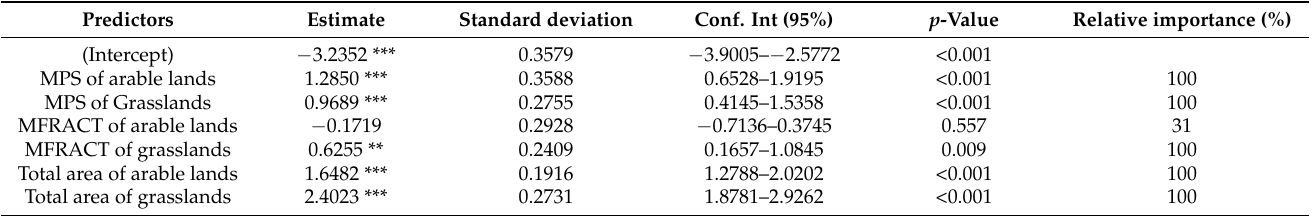
Table A2. Summary table for landscape metrics and LULC categories, which shows the GLM results after multimodel averaging of best candidate models showing relative importance of each explanatory variable on Skylark abundance, estimated parameter values ± Standard deviation. MPS is Mean Patch Size and MFRACT is Mean Fractal dimension.